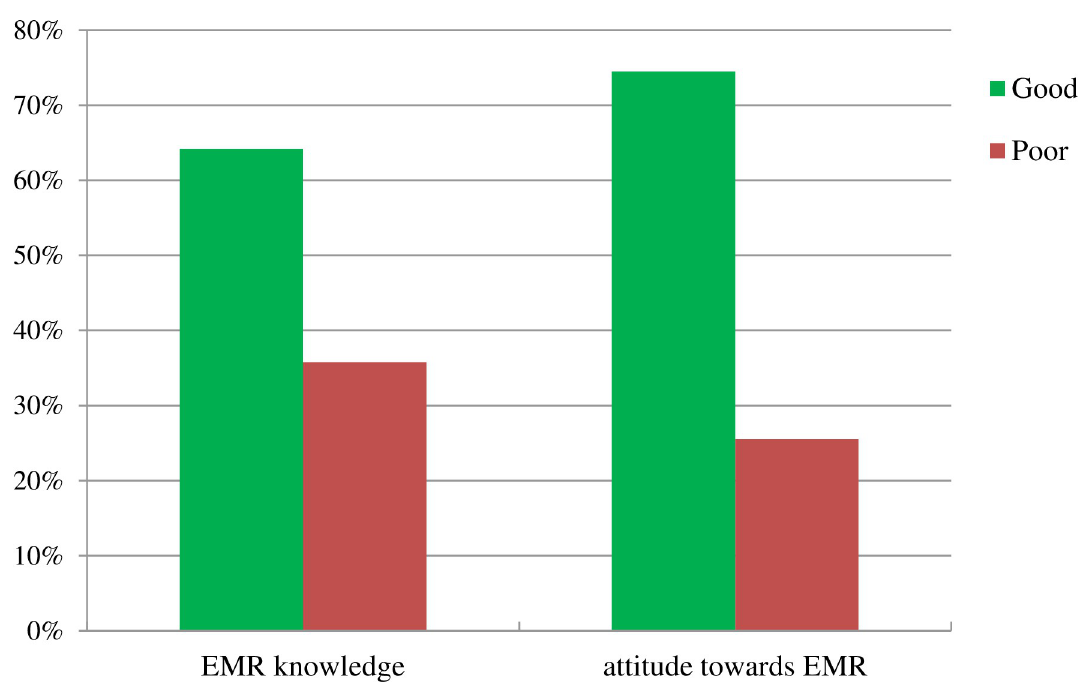
Fig 1. EMR knowledge and attitude towards EMR among health professionals working in public general hospitals, Sidama, Ethiopia, 2022.